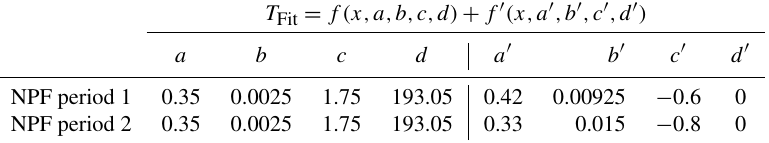
Table 2. List of parameters of the wave fit to identify the wave character of two temperature anomalies, which were coincidently observed with two NPF events, respectively, during the StratoClim flight KTM 6 on 6 August 2017.